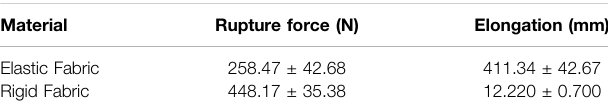
TABLE 3 | Speci fi cations of the materials used in the development of the textile actuator.